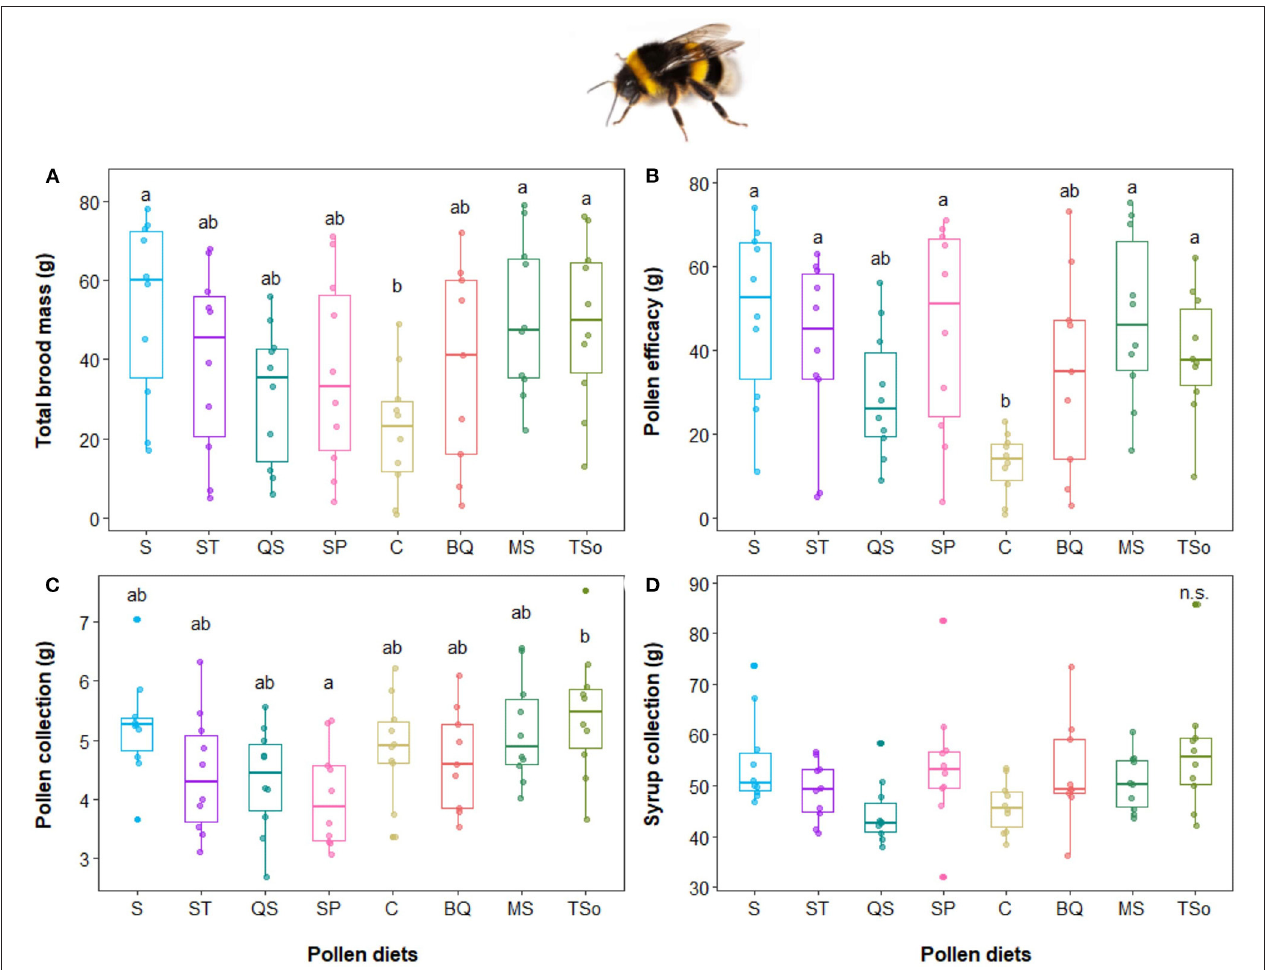
FIGURE 3 | Influence of pollen diets on Bombus terrestris . (A) Brood mass production (g), (B) pollen efficacy (ratio between brood mass and pollen collection), (C) pollen collection (g), and (D) syrup collection. Boxes indicate the 1st and 3rd interquartile range with line denoting median ( n = 10 micro-colonies with 5 workers per pollen diet). Different letters indicate significant differences between pollen diets (ANOVA tests followed by Tukey’s multiple comparison tests: p < 0.05).